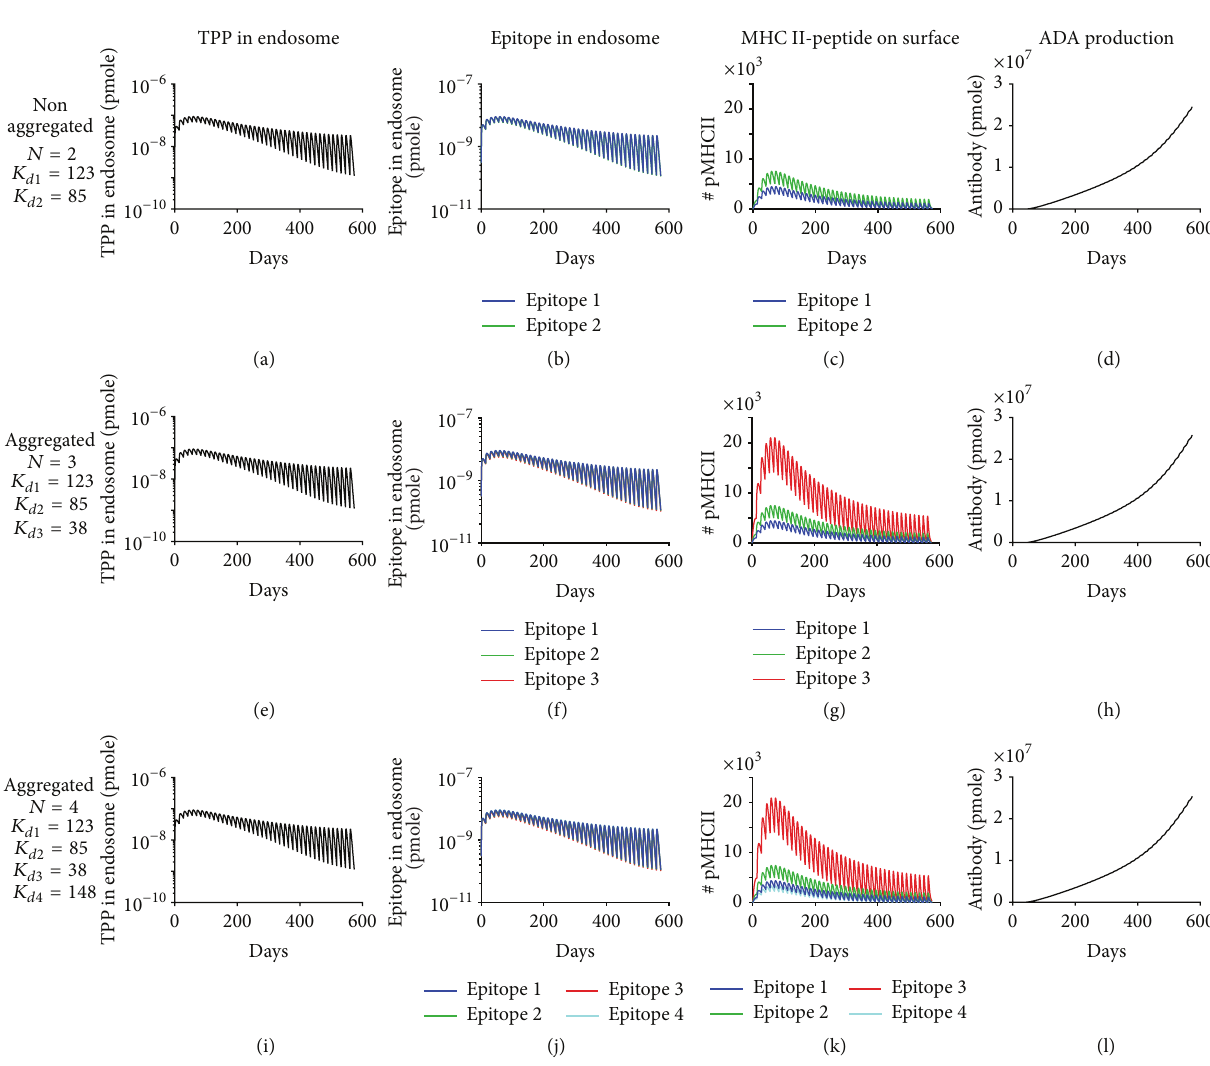
Figure 6: Aggregates could not enhance ADA production by increasing number of epitopes if high affinity epitopes are already present in nonaggregated TPP. Simulated levels of TPP in endosome, epitope in endosome, MHC II-peptide complex on cell surface, and ADA production are shown for ((a)–(d)) original two predicted epitopes for nonaggregated adalimumab [47, 48], ((e)–(h)) three epitopes for hypothetical aggregated form, and ((i)–(l)) four epitopes for hypothetical aggregated form. The predicted dissociation constant ( 𝐾 𝑑 , unit: nM) for binding of each epitope to MHC II is indicated. ADA production has the same definition and dose has the same value as in Figure